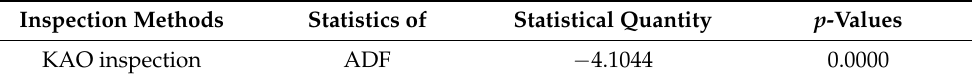
Table 2. Co-integration test results.